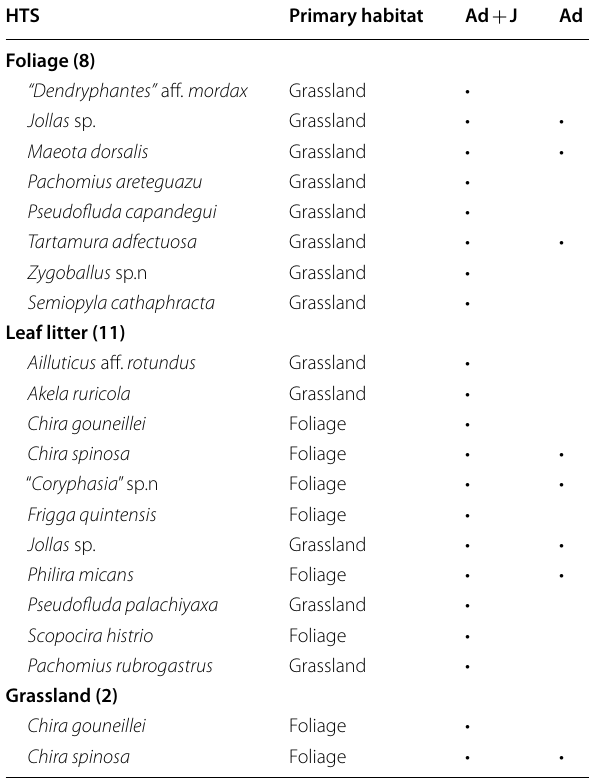
Table 2 HTS in the studied area, Eastern Chaco